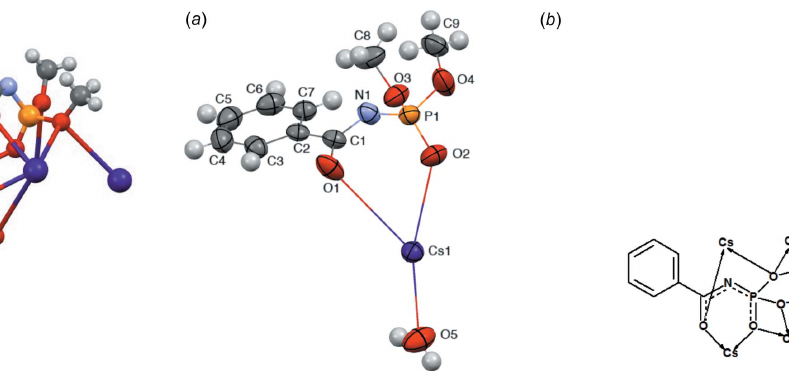
Figure 2 Representation of ( a ) the asymmetric unit of the title compound and ( b ) the coordination mode of L (cid:3)